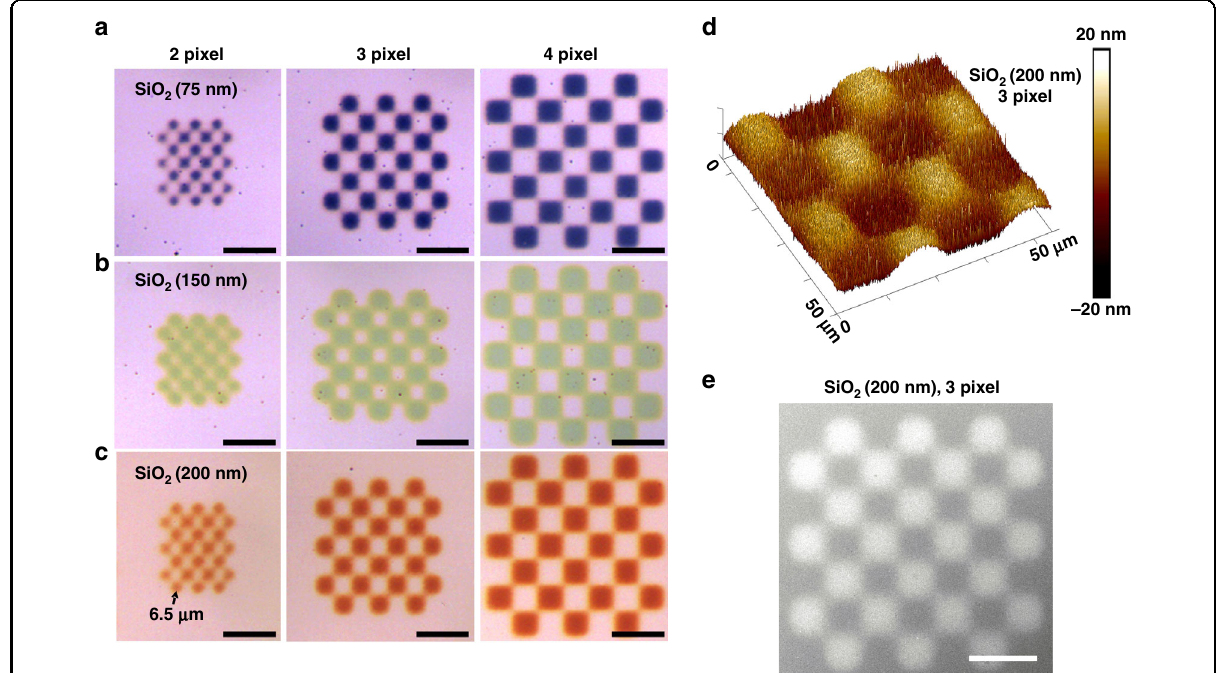
Fig. 4 Experimental demonstrations of color printing with micrometer resolution. a – c Optical images of various pixel-sized checkerboards printed on the SiO 2 /PVD Ag substrate with the SiO 2 thickness as 75, 150, and 200 nm, respectively. Scale bar: 30 μ m. d AFM image and e SEM image (scale bar: 30 μ m) of the printed three pixel-checkerboard on 200 nm SiO 2 layer. The PPD fi lm was ~20 nm